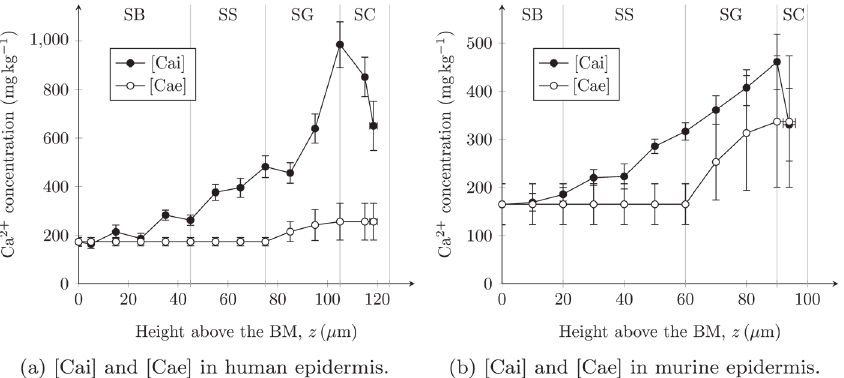
Figure 6. Physical intracellular ([Cai]) and extracellular ([Cae]) epidermal calcium profiles predicted by our model. These profiles are calculated from experimental total calcium profiles reported in [ 26, 28]. [Cae] profiles are shown for TJ barriers that yield a calcium rise through the SG of R ce (cid:4) 1.5: (a) P Ca = 8 nm s − 1 for human epidermis and (b) P Ca = 20 nm s − 1 for murine epidermis.